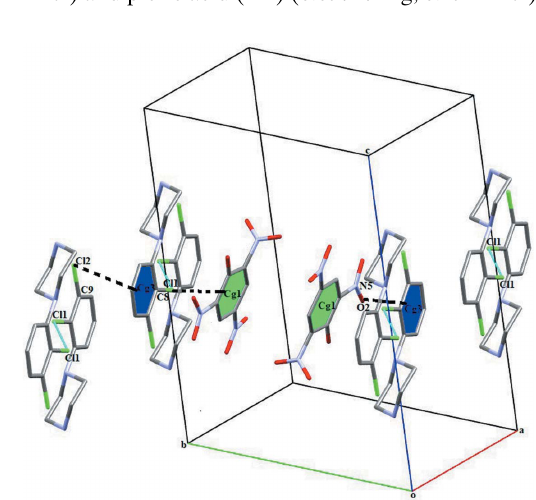
Figure 4 Aview of the C—Cl (cid:3)(cid:3)(cid:3) (cid:2) and N—O (cid:3)(cid:3)(cid:3) (cid:2) interactions involving the phenyl rings of the cation and anion (at symmetry positions x , y , z and 1 (cid:2) x , (cid:2) y , 1 (cid:2) z ) and the weak intermolecular Cl (cid:3)(cid:3)(cid:3) Cl halogen–halogen